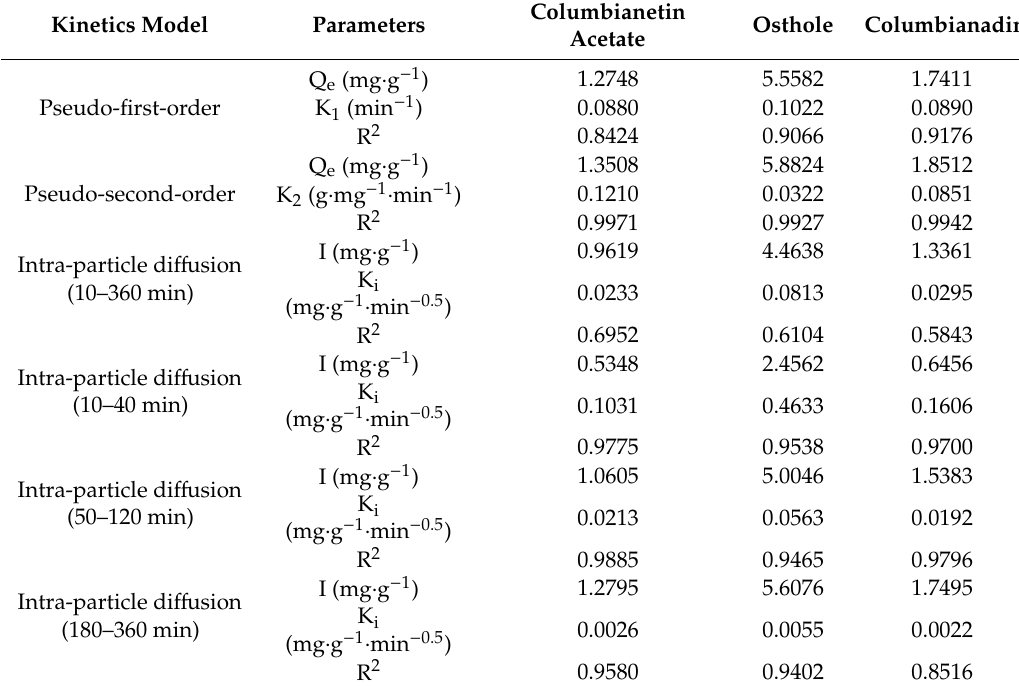
Figure 3. ( A ) Adsorption kinetics curve, ( B ) Pseudo-first-order model, ( C ) Pseudo-second-order model, ( D ) Intra-particle diffusion model of three coumarins on HP-20 resin at 298 K. Adsorption capacity at time t (Q t ). Table 2. Adsorption kinetics parameters of three coumarins on HP-20 resin at 298 K.